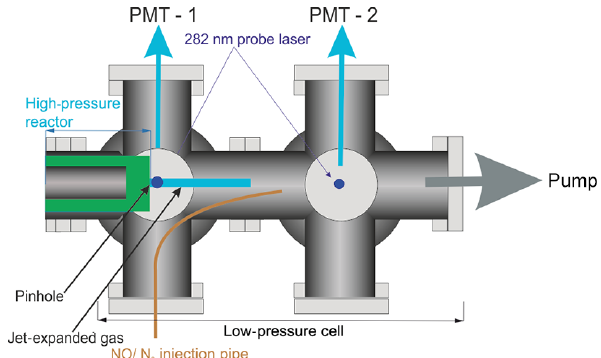
Figure 2. Detailed schematic elevation of the low-pressure detec- tion region of the reactor. The blue line represents the jet-expanded gas; the jet breaks down after approximately 2cm. NO was injected through a 1.5mm i.d. stainless-steel tube after the breakdown of the